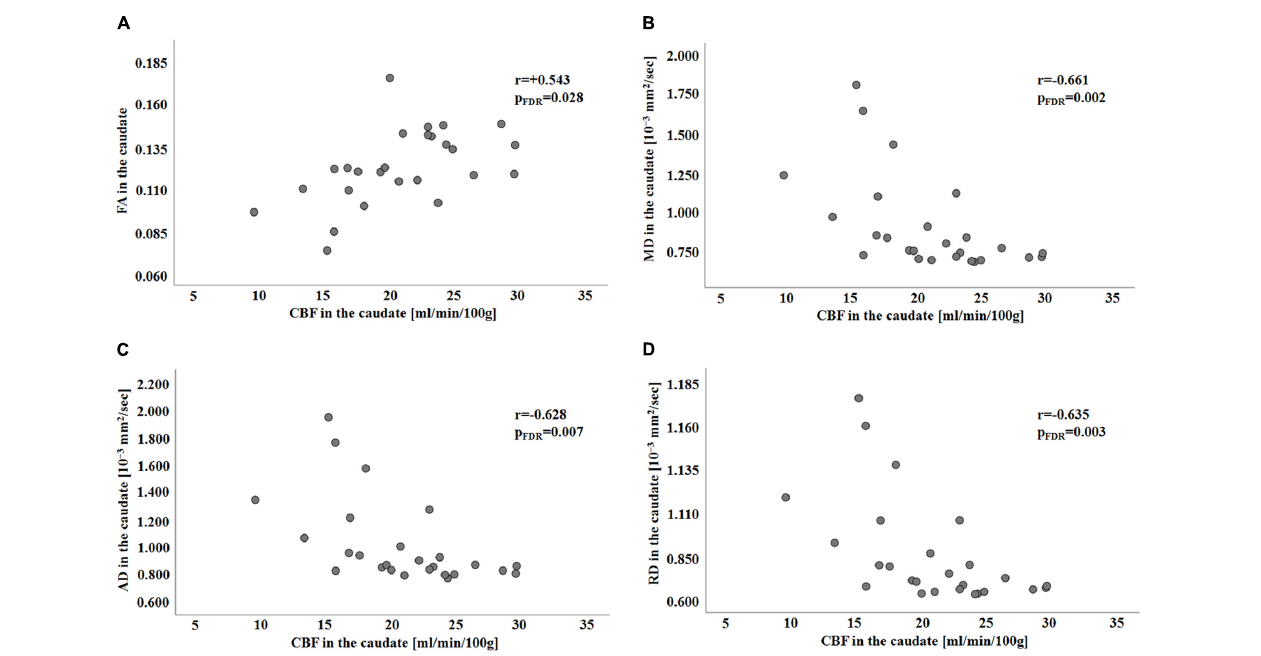
FIGURE 1 | Scatterplots showing FA, MD, AD, and RD in the caudate in relation to CBF in the PD group (panel A–D , respectively). Spearman’s correlation coefficients and associated FDR-corrected p -values are shown (significant for p FDR < 0.05). CBF, cerebral blood flow; FA, fractional anisotropy; FDR, false discovery rate; HC, healthy control; MD, mean diffusivity; AD, axial diffusivity; PD, Parkinson’s disease; r-Spearman’s correlation coefficient; RD, radial diffusivity.